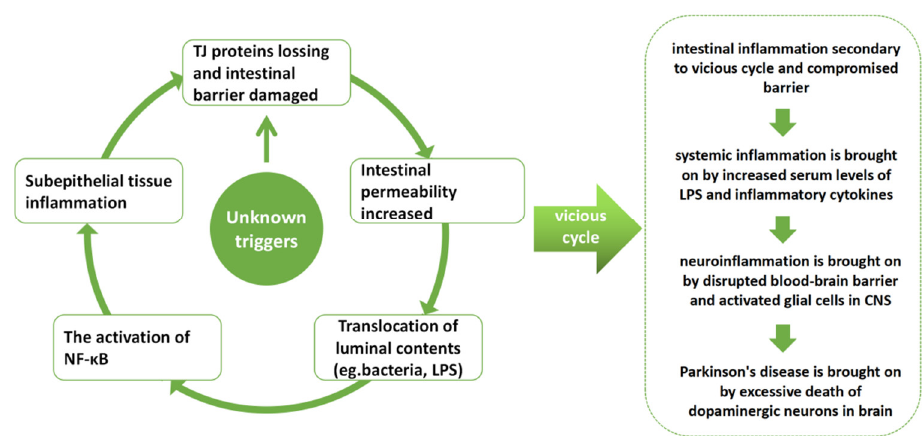
Figure 1. According to our hypothesis, the deficiency of tight junction proteins and enhanced gut barrier permeability, which will allow for the translocation of bacteria and other luminal content, local activation of the NF-κB signaling pathway, and inflammation of the intestinal wall tissue, are all key processes for the vicious cycle secondary to the damaged intestinal barrier. Eventually, inflammation creates a vicious loop by aggravating the damage to the intestinal barrier.